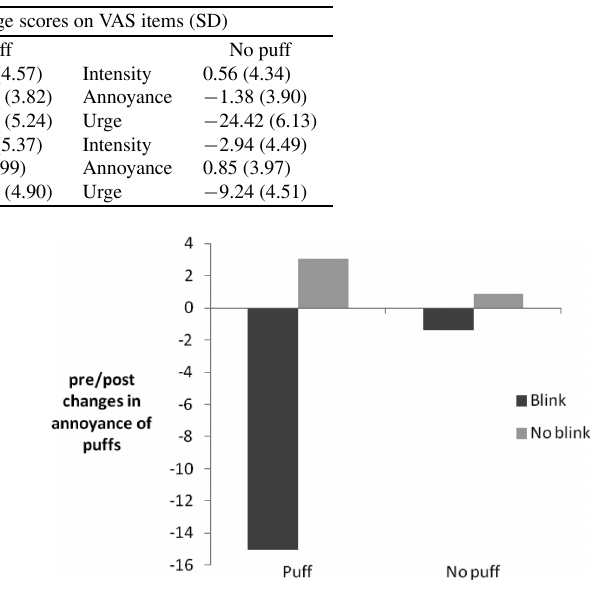
Table 1 Means and standard deviations of change scores on the three VAS items